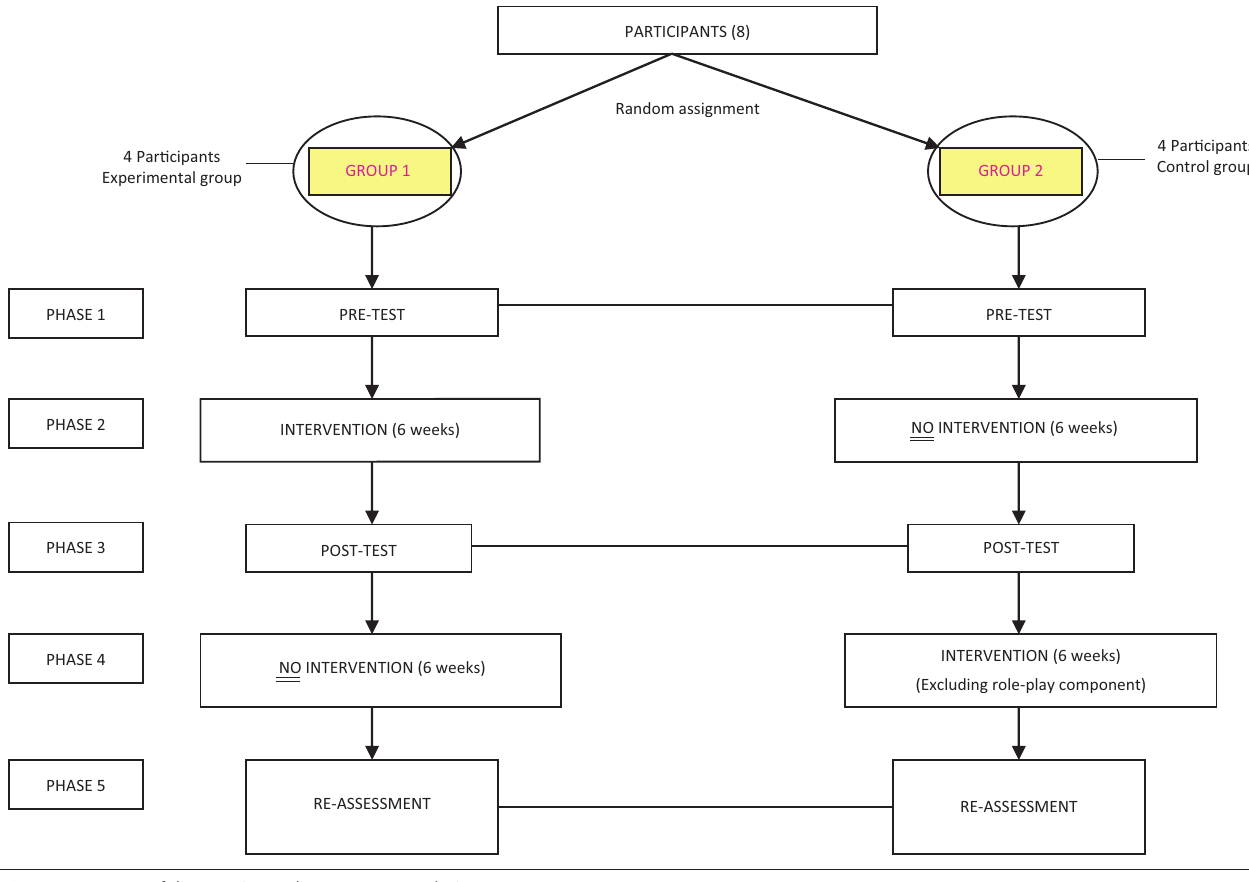
FIGURE 1: Structure of the experimental pretest-posttest